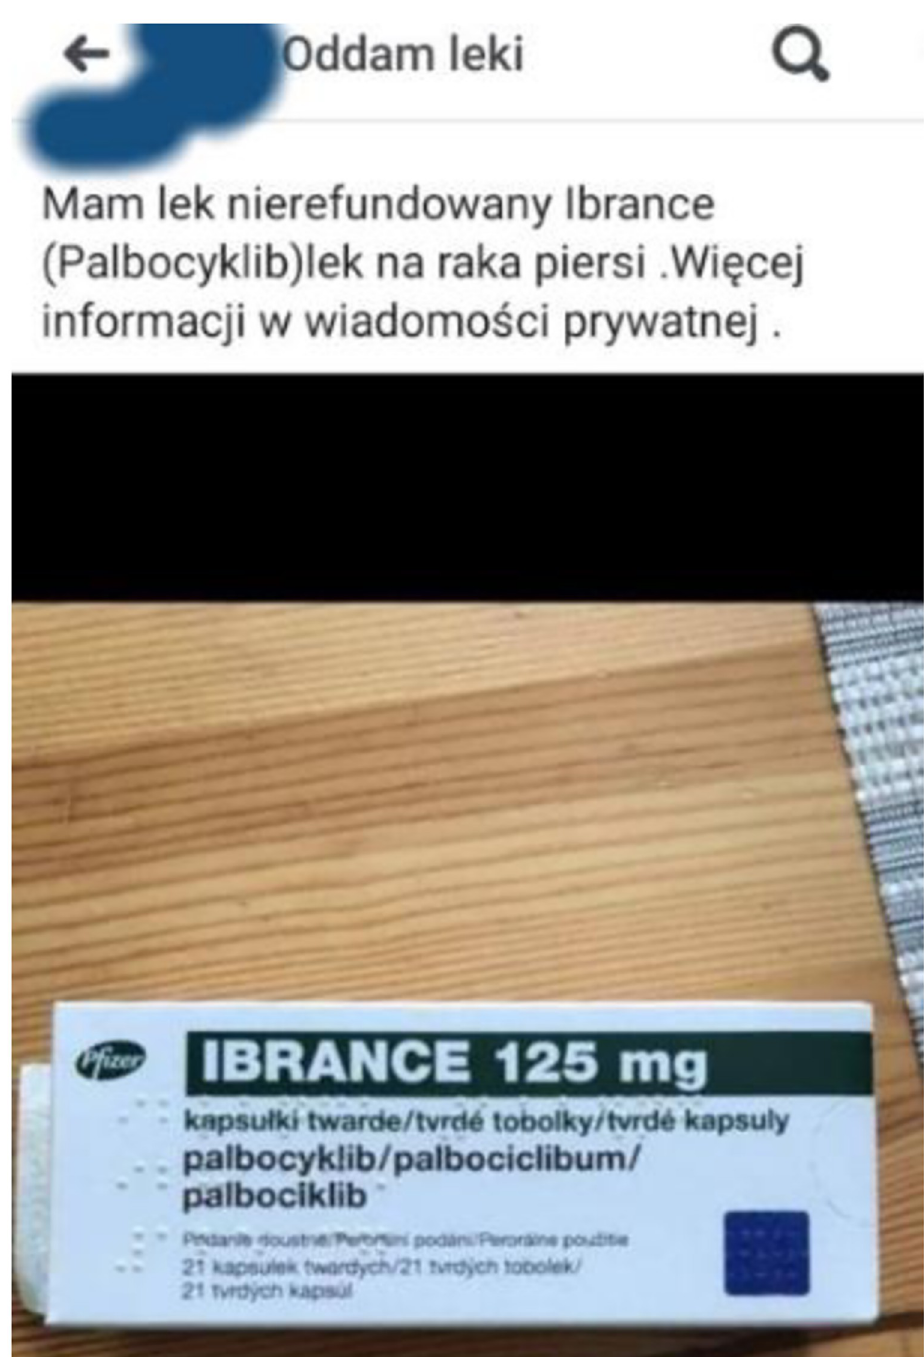
Fig 3. The example of the illegal online trade of medicines. Offer for palbociclib (Ibrance 1 ). Source: Facebook. The URL address was not collected and is not reported to avoid the possible traceability of the Facebook user and to not to contravene the data protection or the GDPR. The presented figure is similar but not identical (partial screenshot with concealed parts of the picture) to the original image and is therefore only for illustrative purposes.